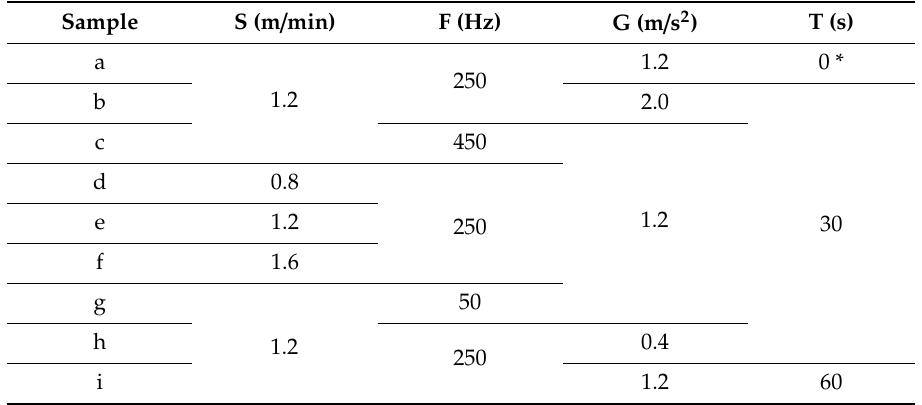
Table 2. The nine representative condition sets of welding speed and sine-mode vibration parameters in tandem-wire pulsed gas metal arc welding